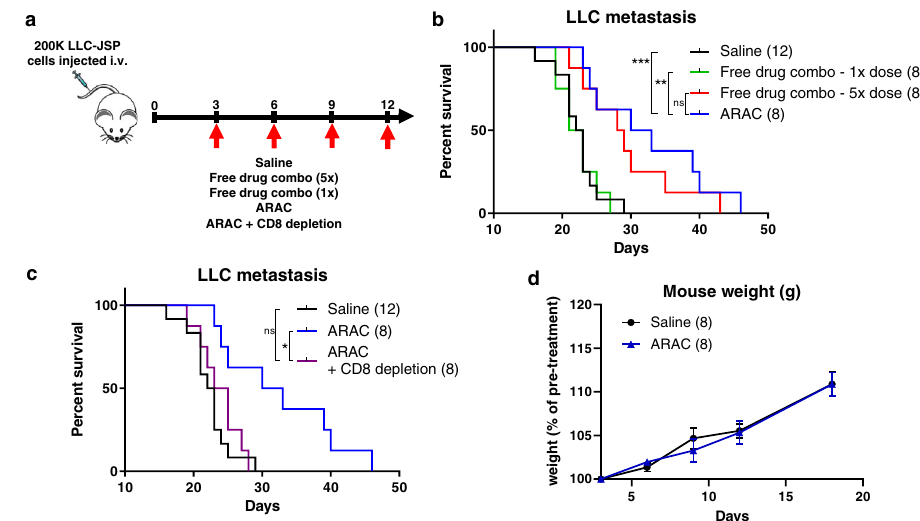
Fig. 6 ARAC improves survival of mice bearing metastatic lung tumors. a C57BL/6 mice were injected with 200,000 LLC-JSP cells intravenously. After 3 days, mice were treated with saline, free drugs (i.p., at 1x dose: 2.5 µ g volasertib and 20 µ g PD-L1 and 5x dose: 12.5 µ g volasertib and 100 µ g PD-L1 antibody), ARAC (i.v., containing 2.5 µ g volasertib and 20 µ g PD-L1), or ARAC + anti-CD8 (200 μ g i.p. twice weekly). Treatments were administered every 3 days for a total of 4 doses. b , c Kaplan – Meier Survival curve. * P = 0.0120, ** P = 0.0033, *** P = 0.0009, ns – not signi fi cant (Log-rank Mantel – Cox test). d Mouse weight change post fi rst treatment; data presented as mean ± SEM. Source data are provided as a Source Data fi le.